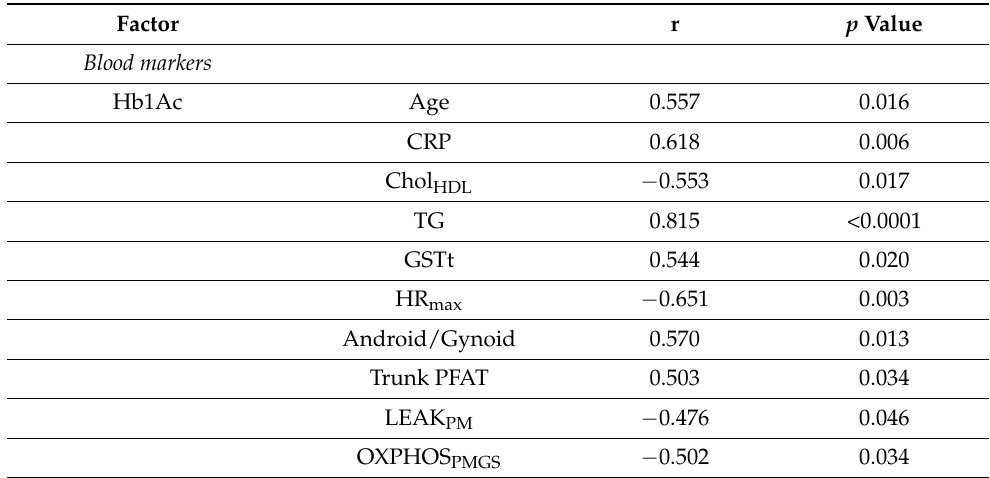
Table 4. Correlation analysis. Pearson’s correlation analysis between individual values of the factors considered in the whole